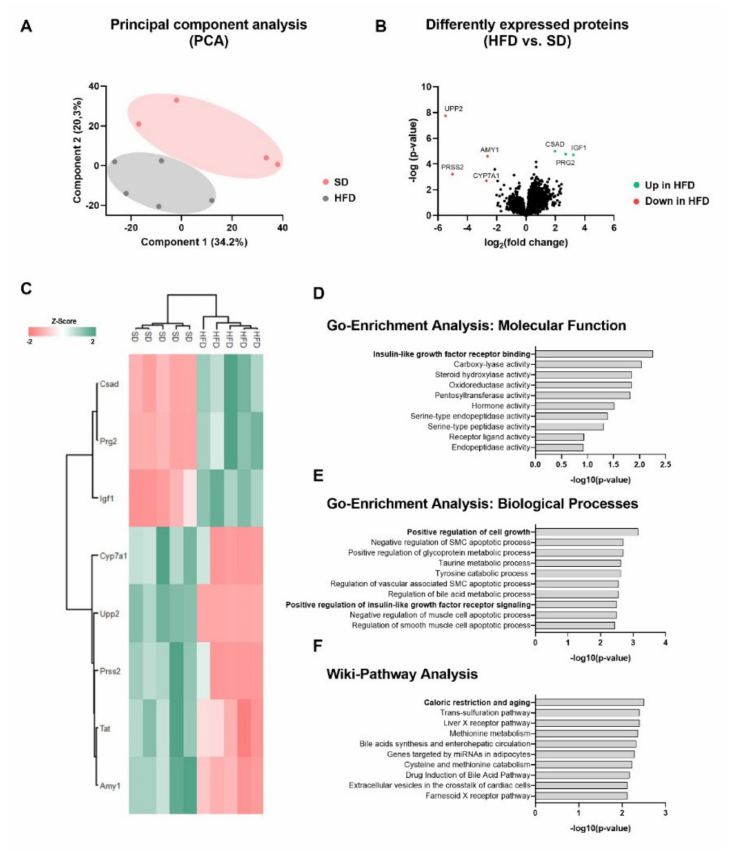
Figure 2. Perinatal obesity determines hepatic proteome signature in the offspring at postnatal day (P) 21. ( A ) Principal component analysis (PCA) with group specific clustering of protein expression variances between SD and HFD samples. ( B ) Volcano plot of univariate statistical analysis results from liver tissue samples of SD and HFD offspring. A volcano plot based on the fold change (Log2) and p value ( − Log10) of all proteins identified in both groups. Green and red dots indicate the up- and downregulated proteins, respectively, that showed statistically significant changes using FDR and q -value < 0.05 for statistical analysis. ( C ) Heatmap of unsupervised 2-dimensional hierarchical clustering of the proteome profile of significantly altered proteins. The normalized Z-Score of protein abundance is depicted by a pseudocolor scale with red showing negative difference, white showing equal expression and green positive differential expression compared with the values of each protein. ( D – F ) Functional enrichment analysis to identify functional protein sets, including molecular functions ( D ), biological processes ( E ) and affected Wiki-pathways ( F ) of liver proteins that displayed significantly changed levels among SD and HFD offspring at P21 (n = 5 per